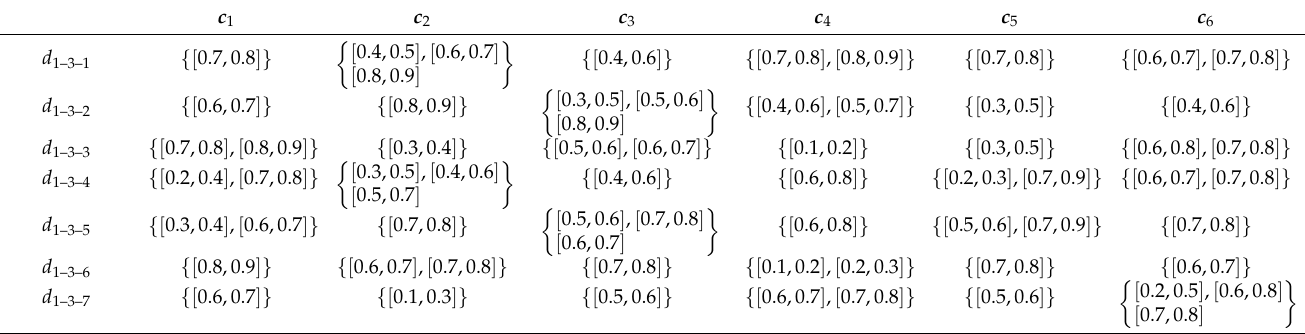
Table A3. Scoring matrix of solvency d 1–3